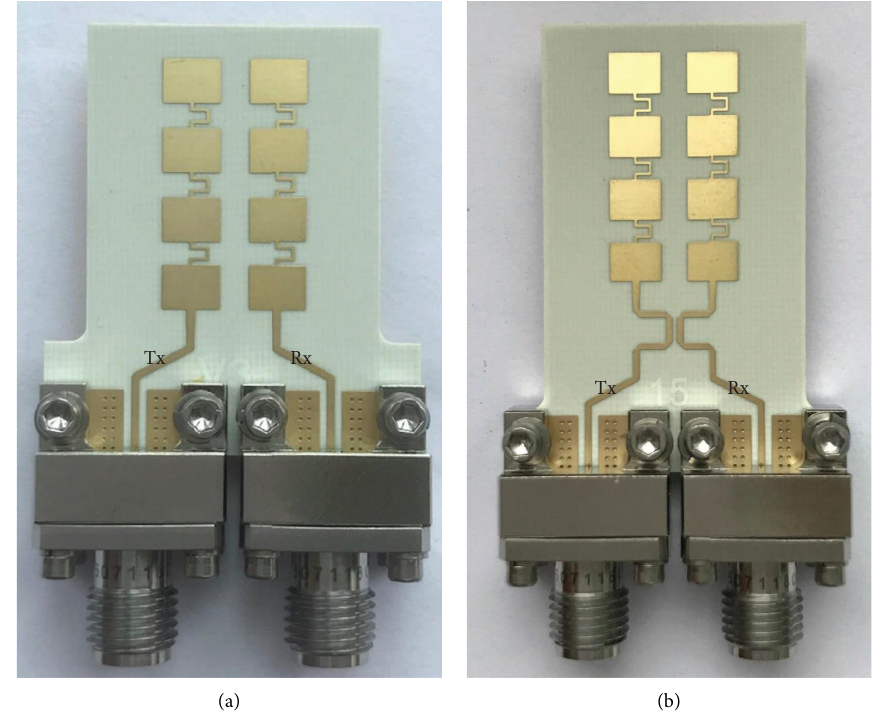
Figure 15: Pictures of the Tx/Rx antennas (a) without and (b) with the decoupling of the Tx/Rx antennas without and with the proposed decoupling network, respectively. Te Tx/Rx antennas without the decoupling network had 15 dB BWs (FBWs) of 23.98–24.43 GHz (1.87%) and 23.98–24.50 GHz (2.16%), Figure 14. Te 20 dB directional coupler and adjacently respectively. Te Tx/Rx antennas with the decoupling net- spaced Tx and Rx antennas were joined by two transmission work provided 15-dB BWs (FBWs) of 23.80–24.36 GHz lines with characteristic impedance of 50 Ω and electrical (2.32%) and 23.80–24.45 GHz (2.69%), respectively. Each length of 138 ° . Figures 15(a) and 15(b) illustrate the pictures measured return loss of the proposed Tx/Rx antennas was